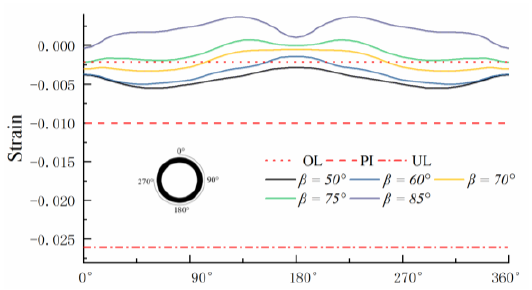
Figure 11. Axial strain distribution curve of the section corresponding to the peak strain of the steel tube at different dip angles of faults ( Δf = 8 cm; stiff).